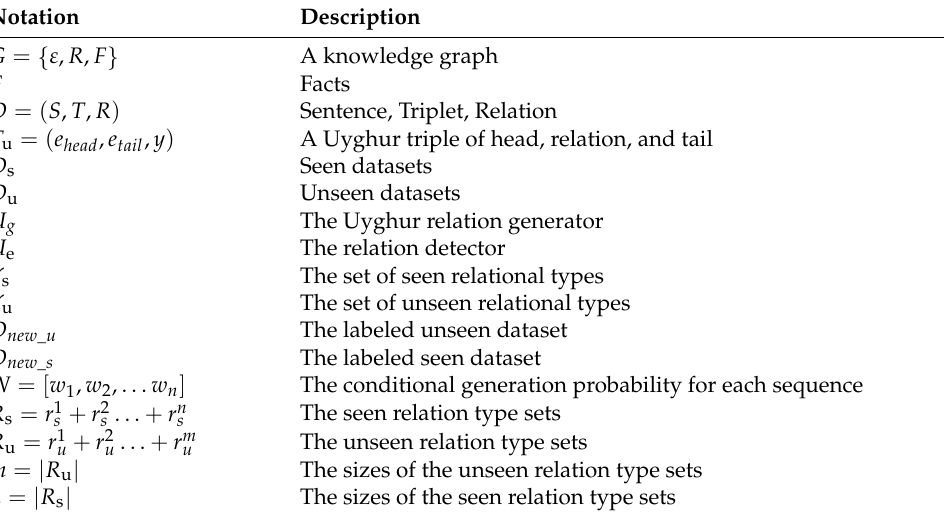
Table 3. Common symbolic descriptions in relationship extraction.